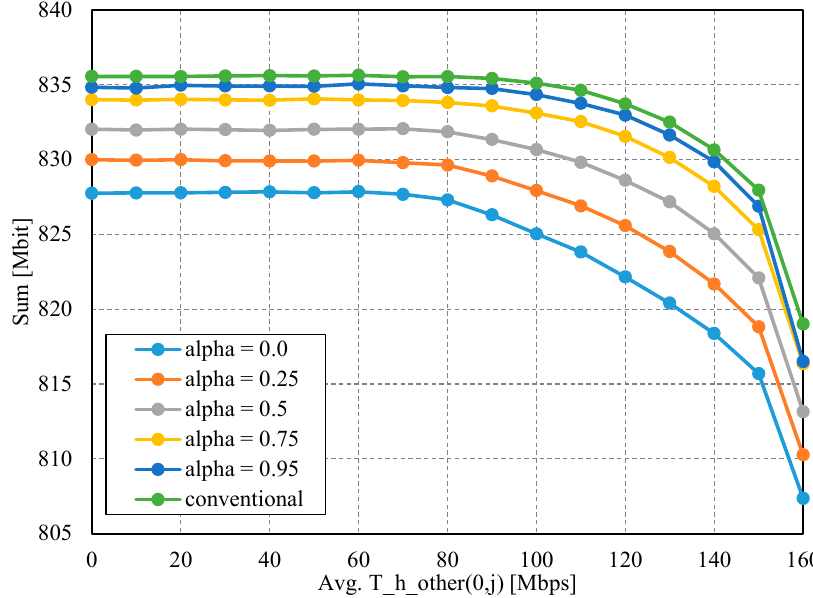
(0, 𝚥)(cid:3364)(cid:3364)(cid:3364)(cid:3364)(cid:3364)(cid:3364)(cid:3364)(cid:3364)(cid:3364)(cid:3364)(cid:3364)(cid:3364)(cid:3364)(cid:3364) with parameter of 𝛼 . ( 0, j ) with parameter of α (cid:3173)(cid:3178)(cid:3166)(cid:3163)(cid:3176) other